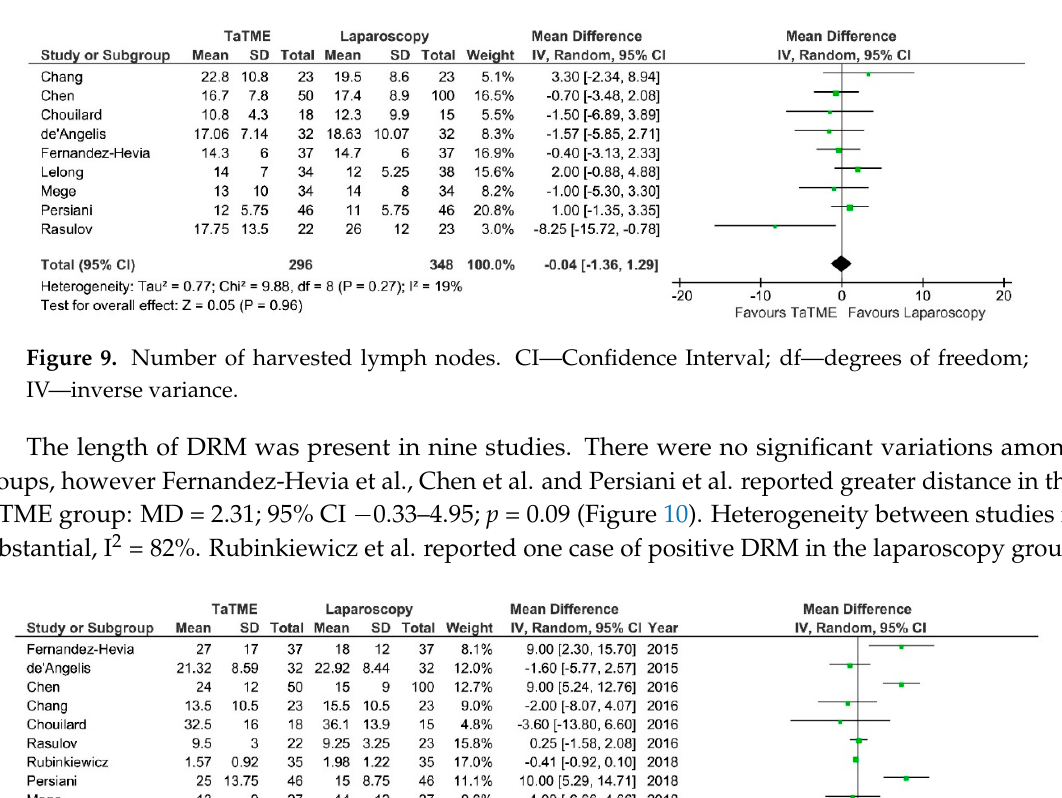
Figure 10. Length of distal resection margin. CI—Confidence Interval; df—degrees of freedom; IV—inverse variance. WMD and RR are presented on the graphs as squares, and overall WMD and RR is